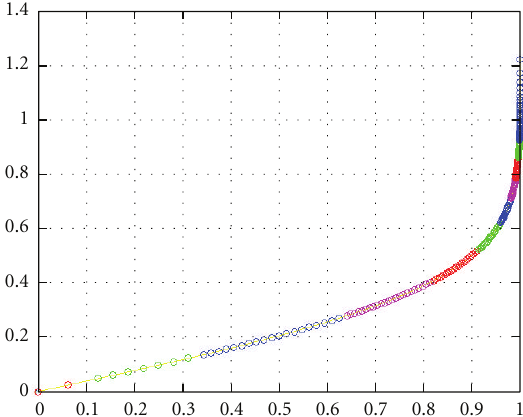
Figure 4: First quadrant of Gaussian transformation function (14) sampled according to the scheme α presented in Tables 1 and 2.